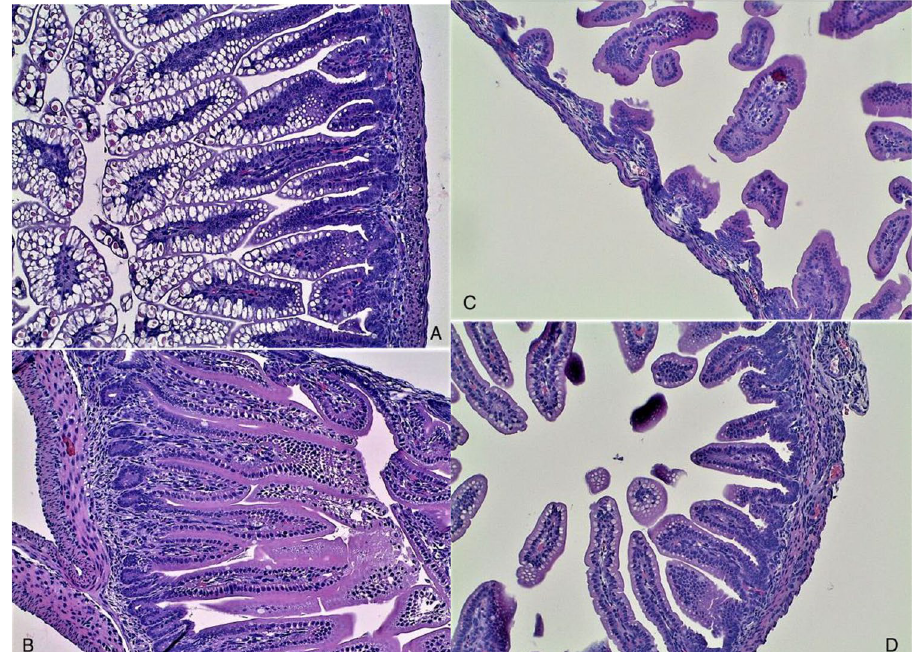
Figure 5. Histopathological analysis of NEC intestinal injuries. (A) Negative control group—normal villi: normal length and appearance. (B) Negative control group—Intact and preserved intestinal wall. (C) Group submitted to the NEC protocol—villous flattening, reduction in number of villi and thinning of the intestinal wall. (D) Group submitted to the NEC protocol—villous flattening and reduction in number of villi.